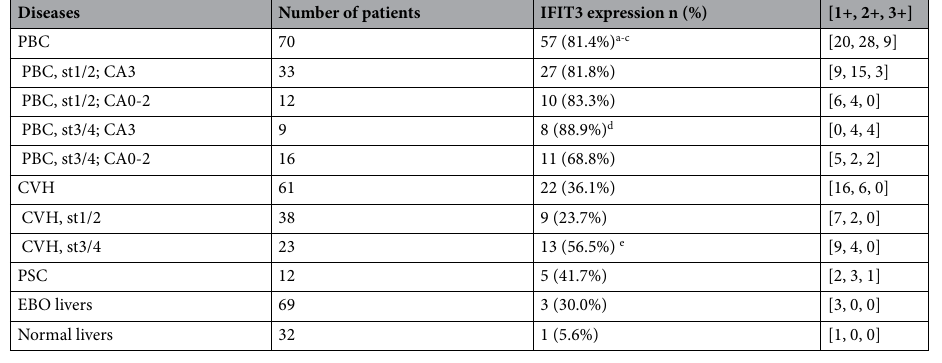
Table 3. Frequency of the expression of Interferon-induced protein with tetratricopeptide repeats 3 (IFIT3) in bile ductules in primary biliary cholangitis and control livers. PBC, primary biliary cholangitis; CVH, chronic viral hepatitis; PSC, primary sclerosing cholangitis; EBO, extrahepatic biliary obstruction; a, p < 0.01 versus CVH; b, p < 0.01 versus EBO; c, p < 0.01 versus Normal livers; d, p < 0.05 versus stage 3/4, CA0-2; e, p < 0.01 versus CVH, stage 1/2; n, number; [ ], number of cases showing 1 + (focal, positive cells are detected in one third or fewer portal tracts), and 2 + (moderate, positive cells are detected in bile ductules in more than one third of portal tracts), 3 + (extensive, positive cells are detected in bile ductules in more than two thirds of portal